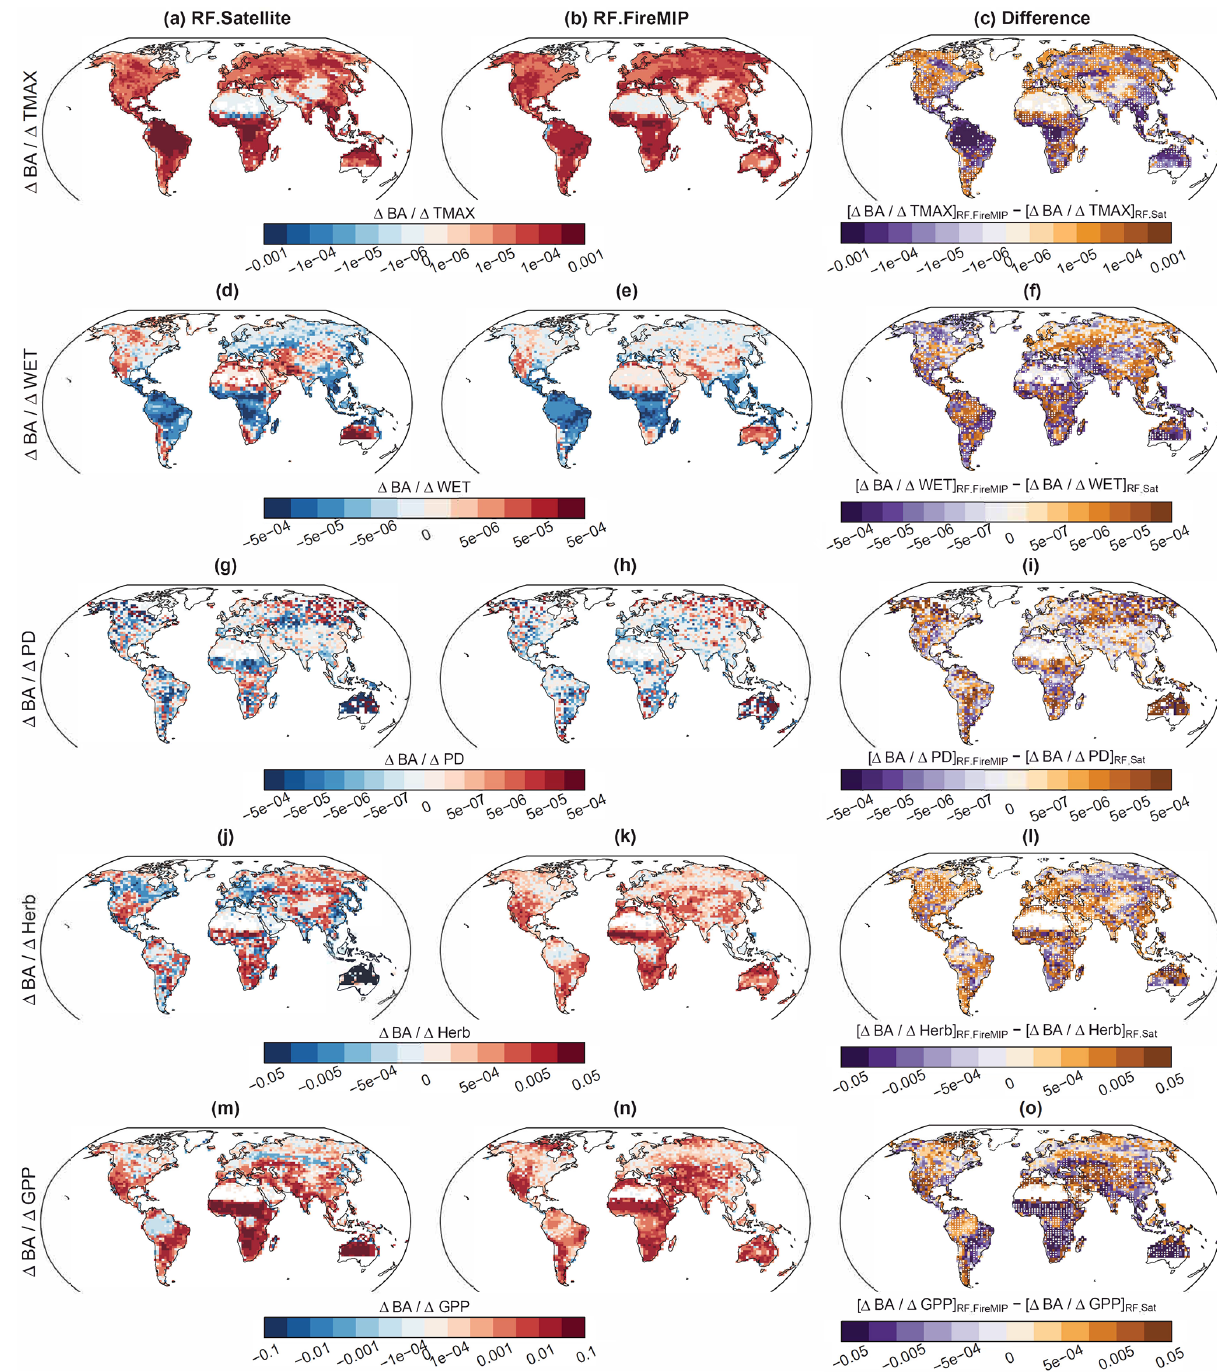
Figure 6. Regional sensitivities of burned area to the driving factors for five selected variables (a–c) maximum temperature, (d–f) number of wet days per month, (g–i) population density, (j–l) herbaceous vegetation cover, and (m–o) precedent 6-monthly GPP. Sensitivities are slopes of a linear quantile regression fit to grid cell-level partial dependencies between burned area and the predictor variables as derived from satellite-derived “fm” RF experiments (left column) and model-derived RF experiments (middle column). The right column shows the difference between model- and satellite-derived sensitivities. Stippling indicates locations where fewer than two model-derived sensitivities are within the range of satellite-derived sensitivities. Sensitivities for individual satellite data sets and FireMIP models are shown in Figs. S18 to S27. Regions with missing data (white) had no vegetation cover (e.g. deserts, ice sheets), had no burned area (e.g. parts of the Amazon and tundra), or were not covered by the vegetation carbon map used (i.e. regions in southern Australia and New